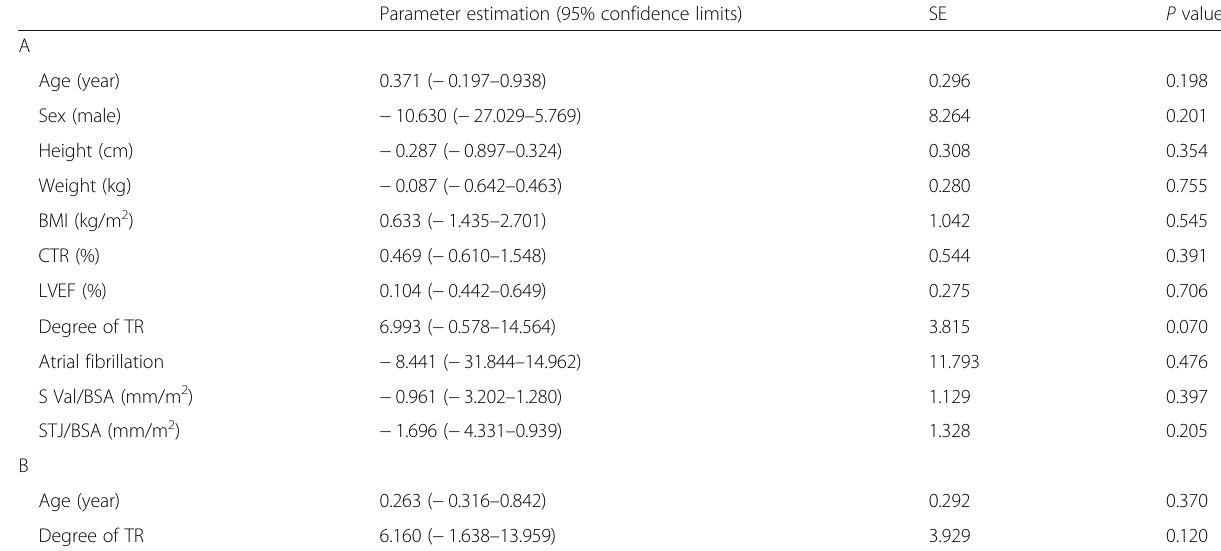
Table 3 Simple (A) and multiple (B) linear regression model of potential predictors of increased time duration to advance the catheter through the tricuspid valve